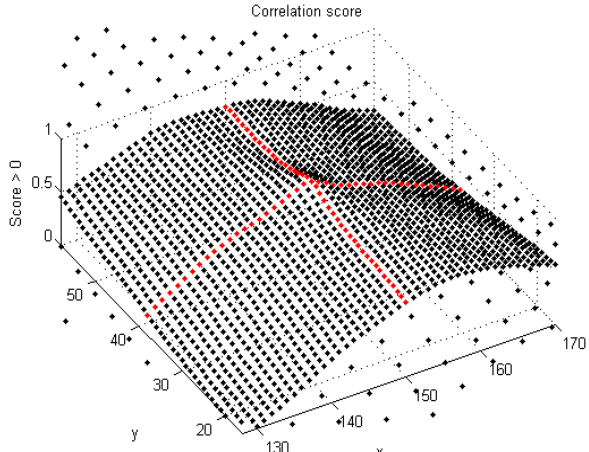
Figure 5. Surface of correlation scores for offsets of ±21 pixels from maximum. Red lines indicate maximum row and column.